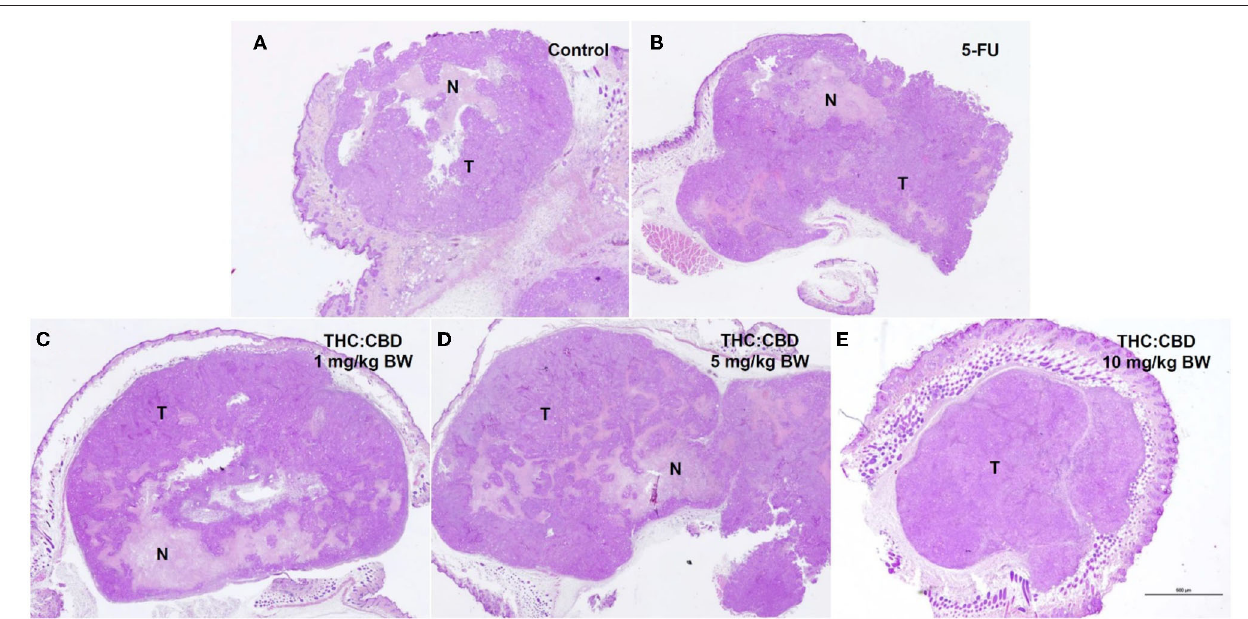
FIGURE 3 | Histopathological morphology of mice in the negative control group (A) , the positive control group (5-FU) (B) , and THC:CBD at dose of 1 mg/kg BW (C) , 5 mg/kg BW (D) , and 10 mg/kg BW (E) , (HE, 2 × ). Tumor masses were presented with necrotic tissue (N). Necrotic tissues were presented in the center and at the edge of the tumor especially in treatment and positive control groups compared with the negative control group.